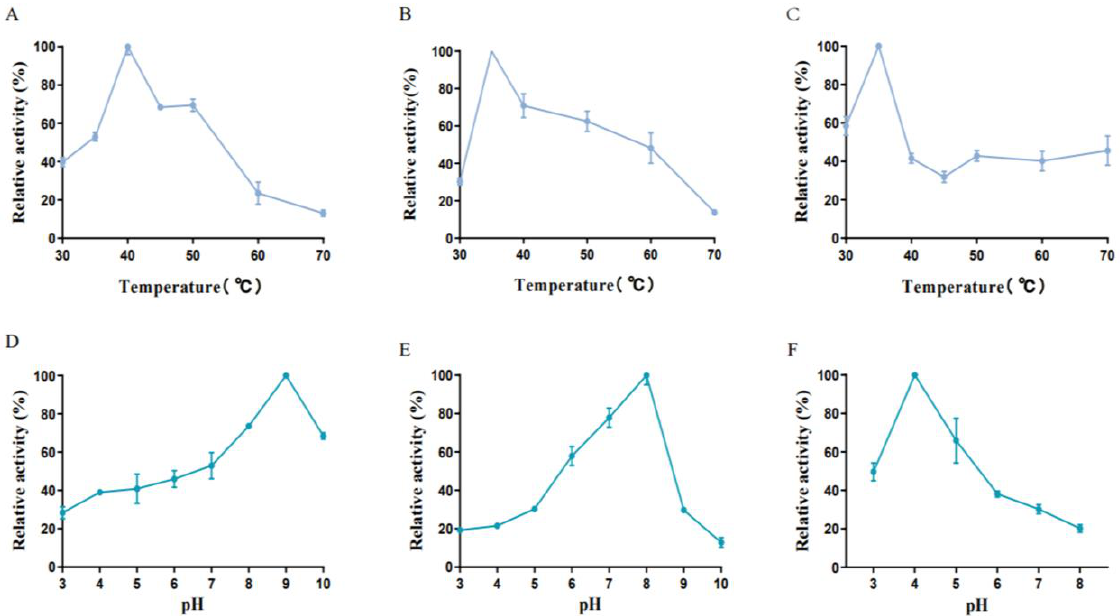
Figure 11. Characterization of purified recombinant enzymes. ( A ) Effect of temperature on FumTSTA catalytic activity; ( B ) Effect of temperature on FumPHTA catalytic activity; ( C ) Effect of temperature on FumUPTA; ( D ) Effect of pH on FumTSTA catalytic activity; ( E ) Effect of pH on FumPHTA catalytic activity; ( F ) Effect of pH on FumUPTA catalytic activity.